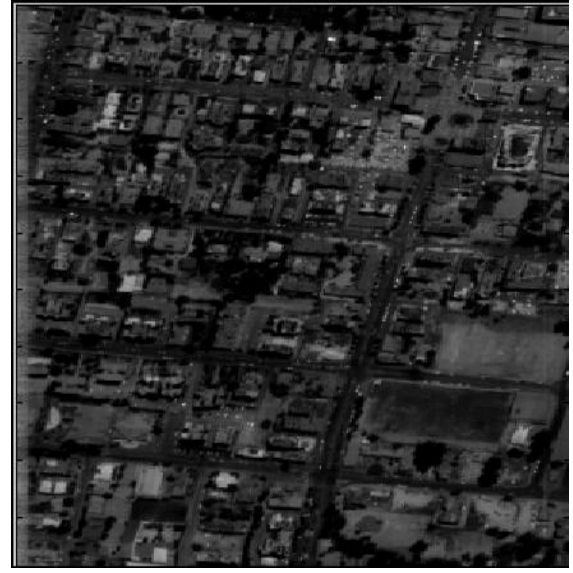
Figure 5. The dataset “city” is an hyperspectral image of a city taken by an airplane flying 10,000 feet above sea level. The resolution is 1.5 m/pixel, 294 × 501 pixels per waveband with 28 wavebands.